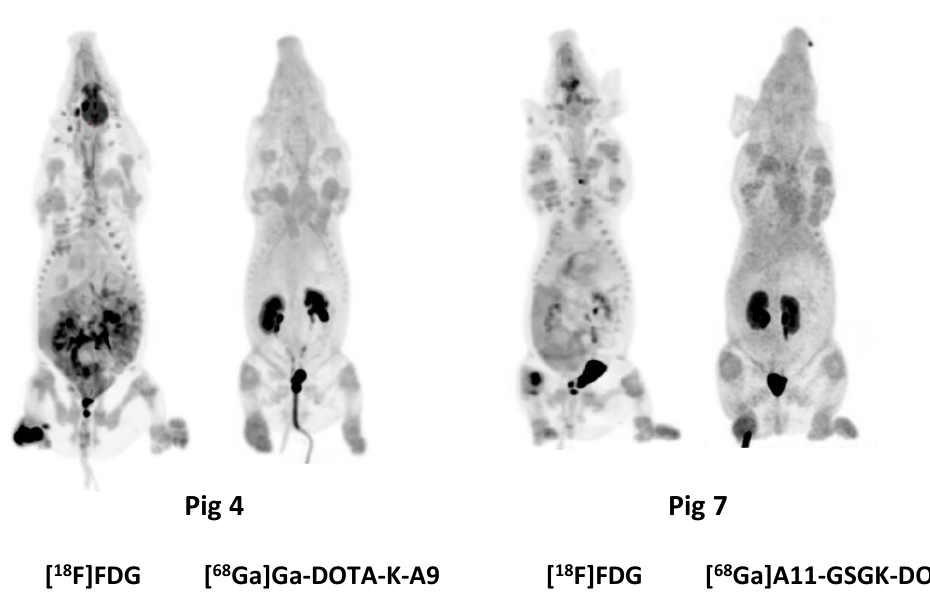
Figure 2. [ 68 Ga]Ga-DOTA-GSGK-A11 compared to [ 18 F]FDG.